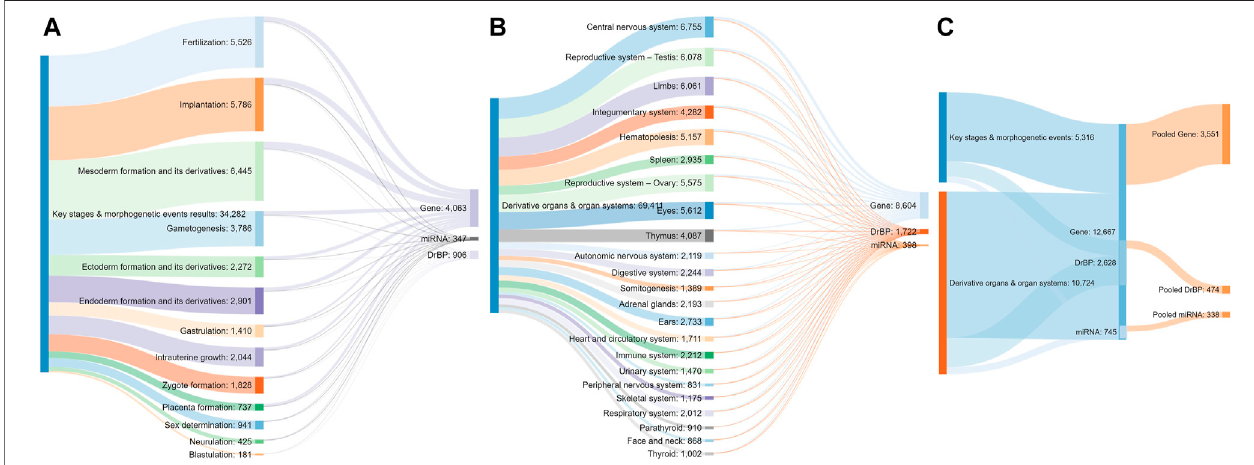
FIGURE5| Sankey diagram indicatingthenumber ofarticles screened for each stage (A) and organ type (B) ,the number ofstage (A) or organ-speci fi c (B) sets of DARS markers extracted and pooled sets of DARS markers (C) .